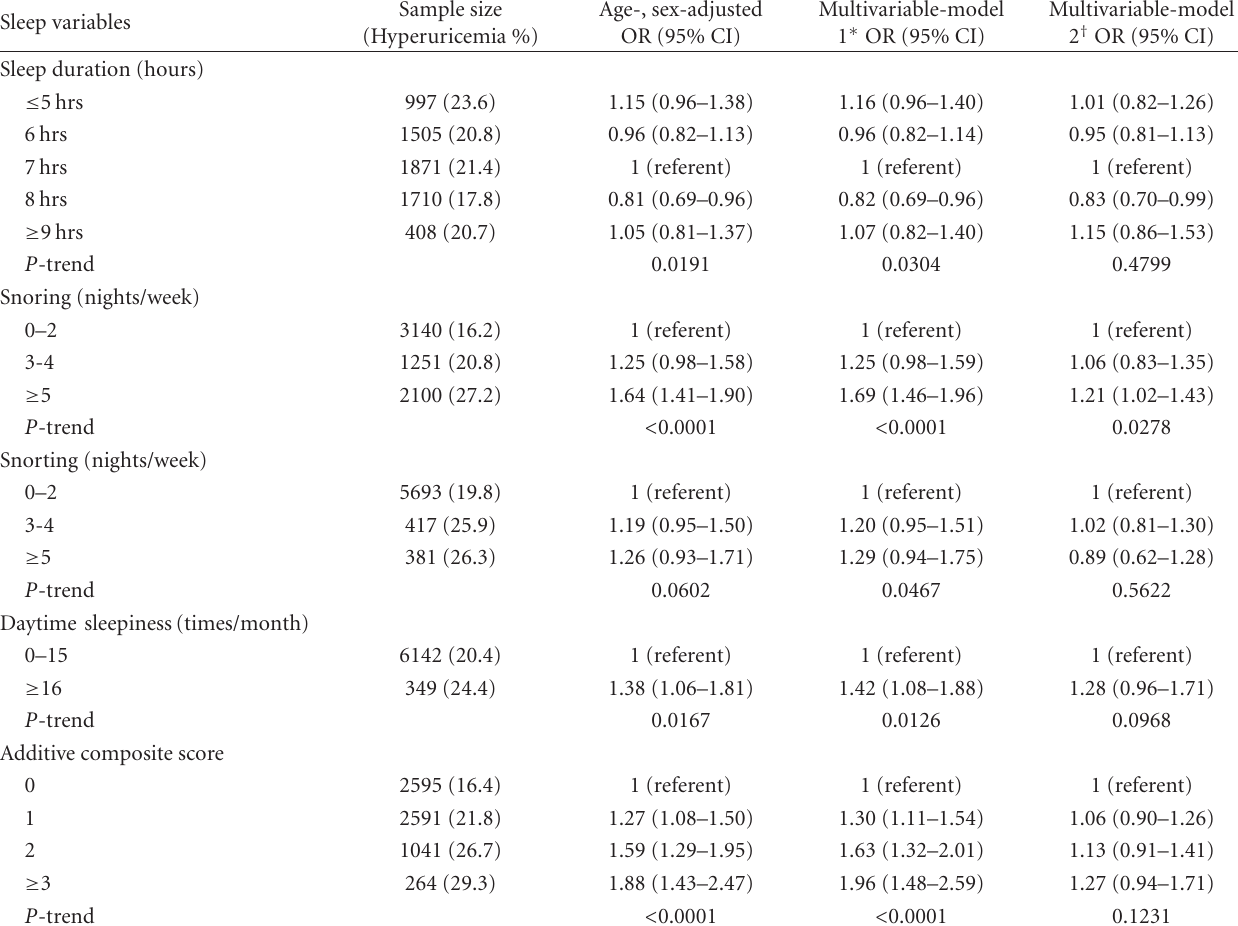
Table 2: Association between sleep variables and hyperuricemia (defined as levels > 6.8 mg/dL in men and > 6.0mg/dL in